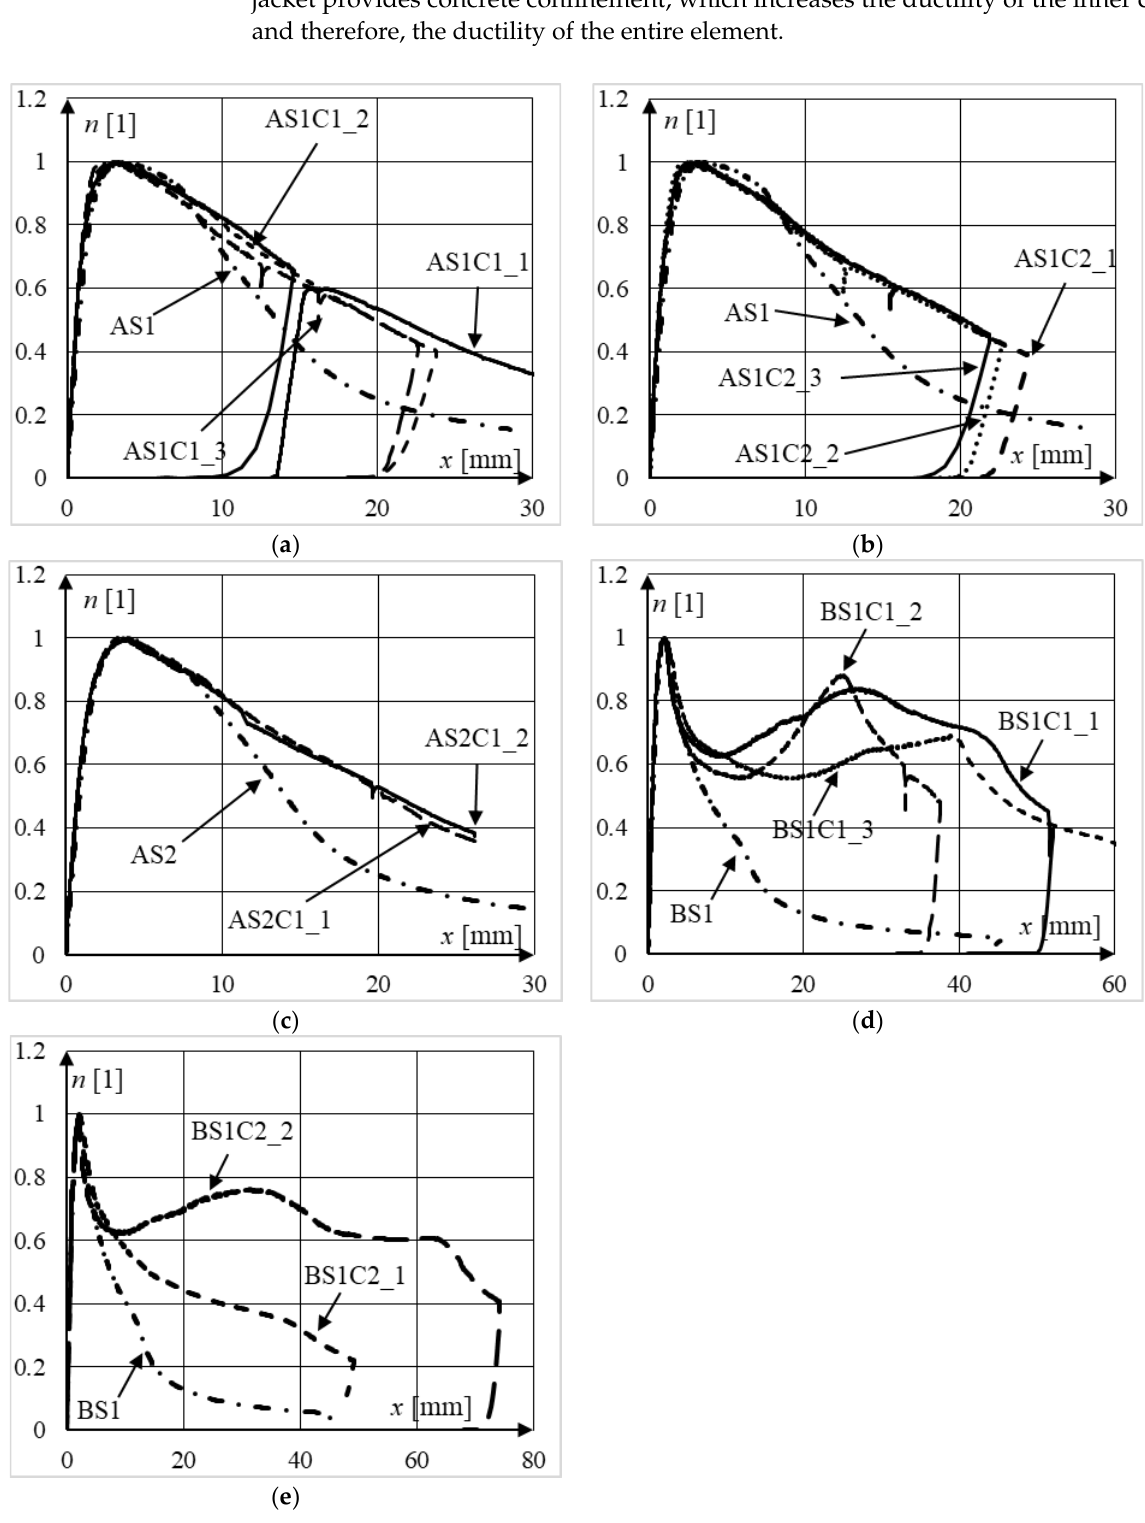
Figure 12. Normalized equilibrium paths of slender elements from series: ( a ) AS1C1; ( b ) AS1C2; ( c ) AS2C1; ( d ) BS1C1; ( e ) BS1C2.